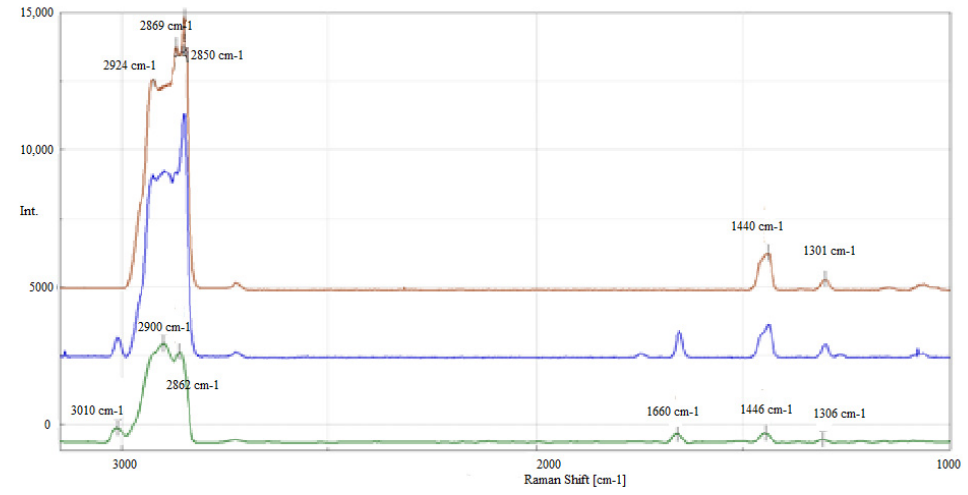
Figure 1. The Raman spectra of vegetable Oil A—green line, vegetable–mineral Oil AF—blue line and mineral Oil F—brown line, in the 3700–1000 cm − 1 range.